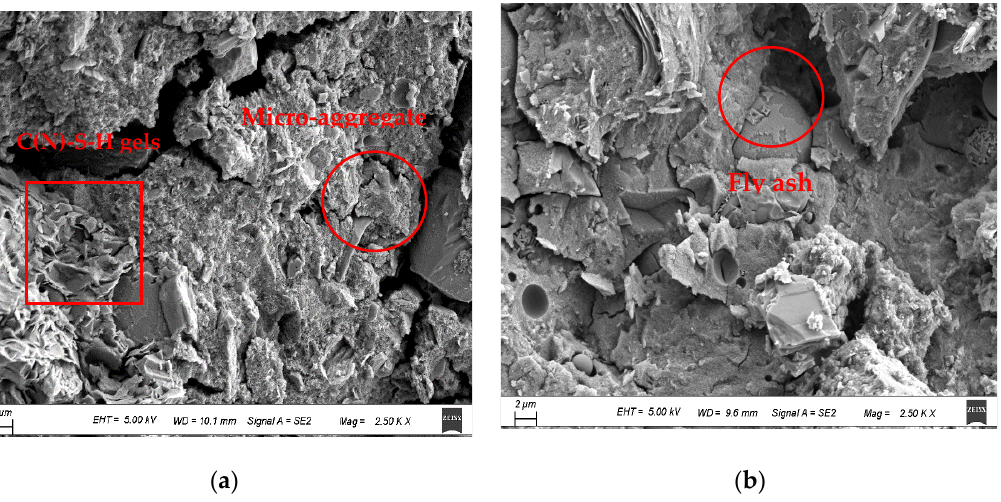
Figure 12. SEM images of AARCPC with different mineral admixtures content. ( a ) R5S5 28 d; ( b ) R6S2F2 28 d.